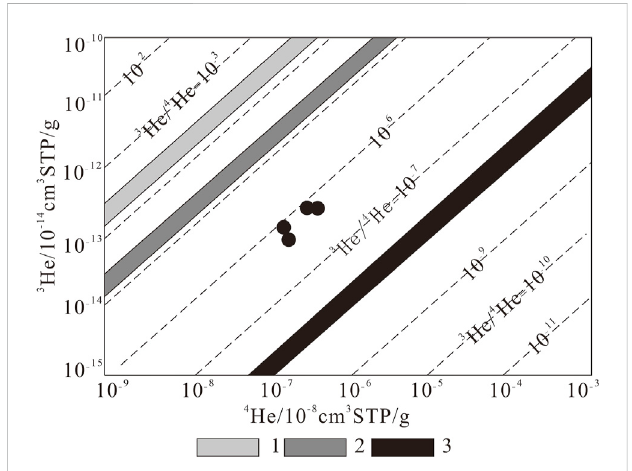
FIGURE 8 Helium isotopic compositions of fl uid inclusions in pyrites from the Yangjiakuang gold deposit (after Mamyrin & Tolstikhin, 1984). 1. Initial argon; 2. Mantle argon; 3. Crustal argon.